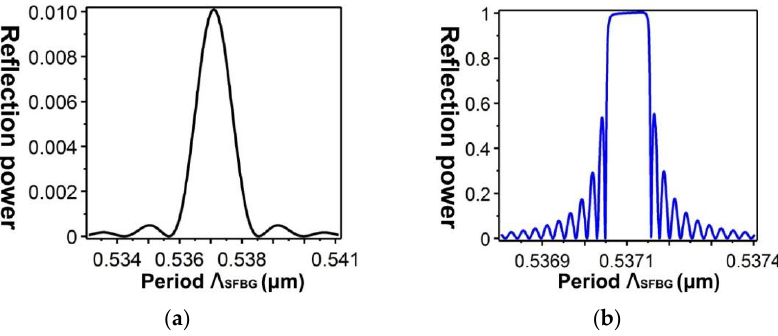
Figure 14. Relationship between the SFBG period and reflection power: ( a ) single SFBG; ( b ) compressed SFBG.